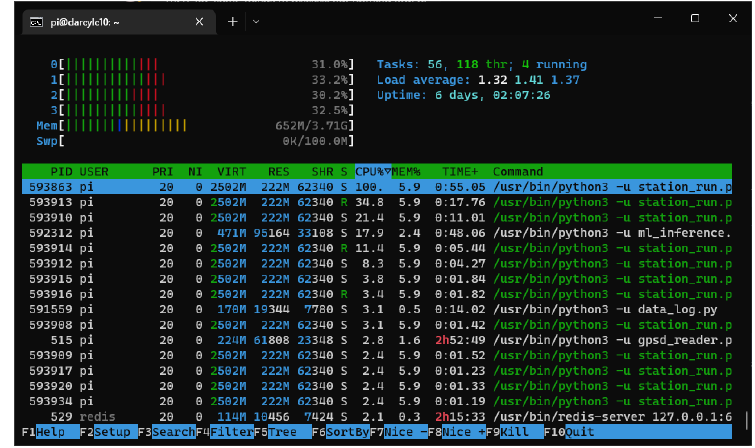
Figure 9. System usage with all modules running according to Profile